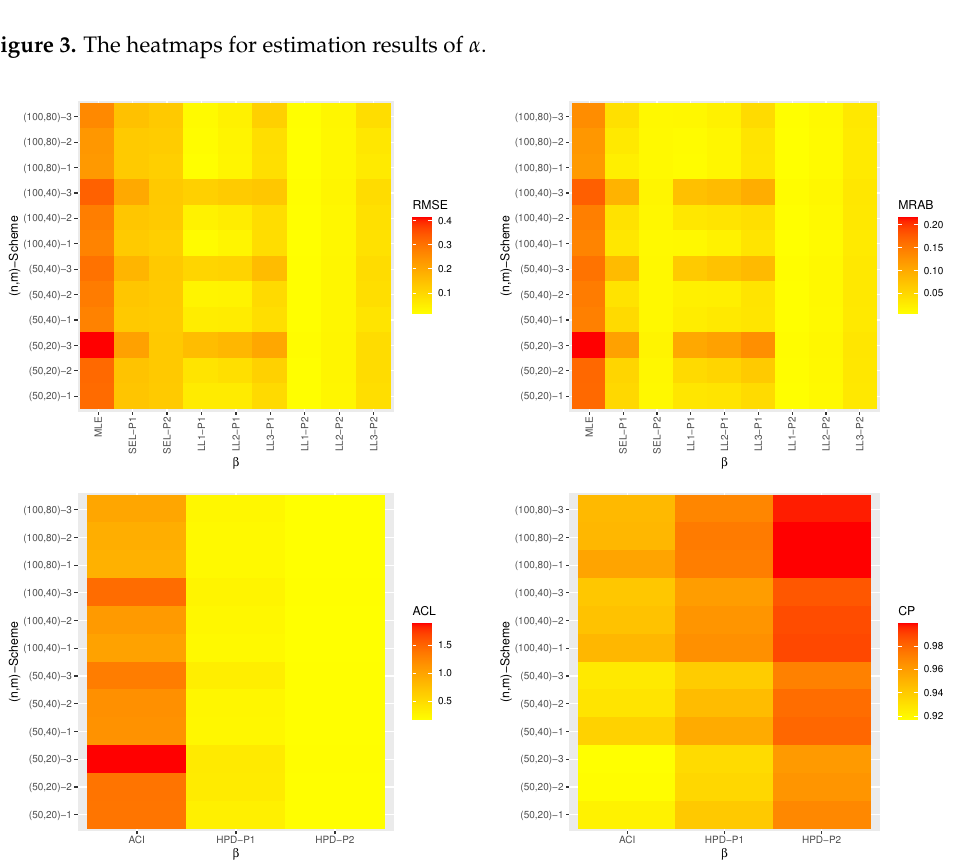
Figure 4. The heatmaps for estimation results of β